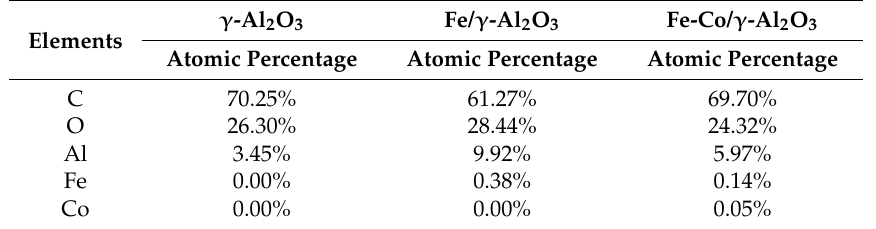
Table 1. The EDS data summary for γ -Al 2 O 3 , Fe/ γ -Al 2 O 3 and Fe-Co/ γ -Al 2 O 3 .